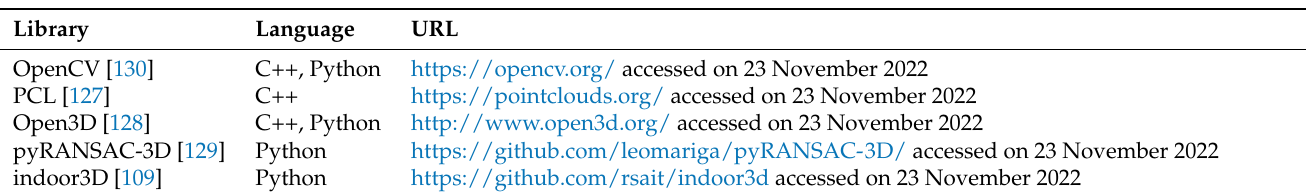
Table 5. Libraries with RANSAC